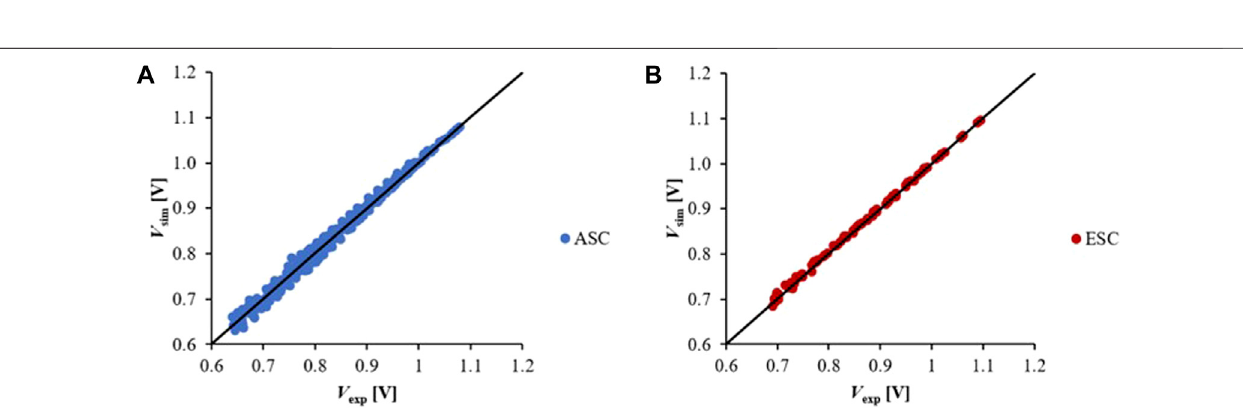
FIGURE 6 | Overpotentials pro fi les at 850 ° C and air as oxidant, changing fuel compositions for (A) ASC and (B) ESC derived from experimental observations.